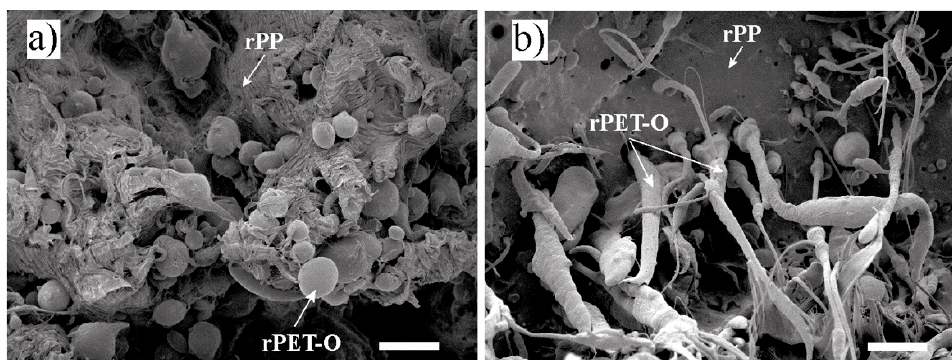
Figure 7. SEM micrographs of the post mortem fracture surfaces (×1500) of ( a ) 80/20 and ( b ) 70/30 rPP/rPET-O blends. Scale bars = 10 mm.